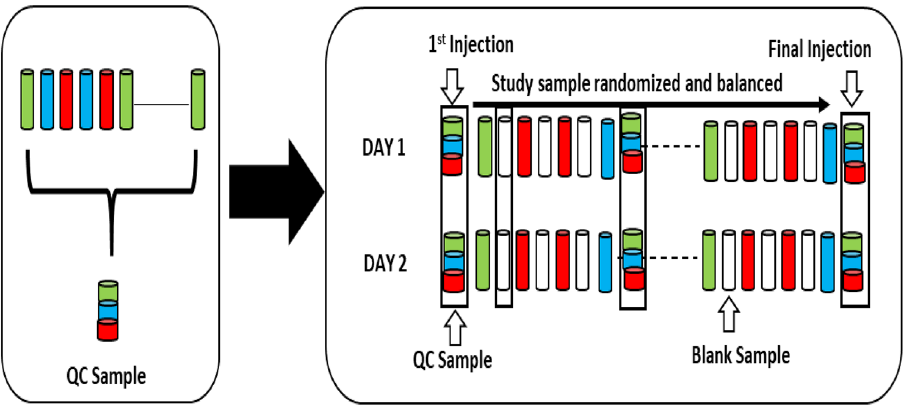
Figure 8. Preparation and scheduling of QC and samples for UHPLC-MS/MS. A small aliquot of each sample (coloured cylinders) was pooled to create a QC sample (multi-coloured cylinder), which was then injected periodically (every 50th injection) throughout the batch run. Variability among consistently detected metabolites was used to estimate overall process and batch variability. Every sample injection was followed by a blank injection to prevent carryover between the sample